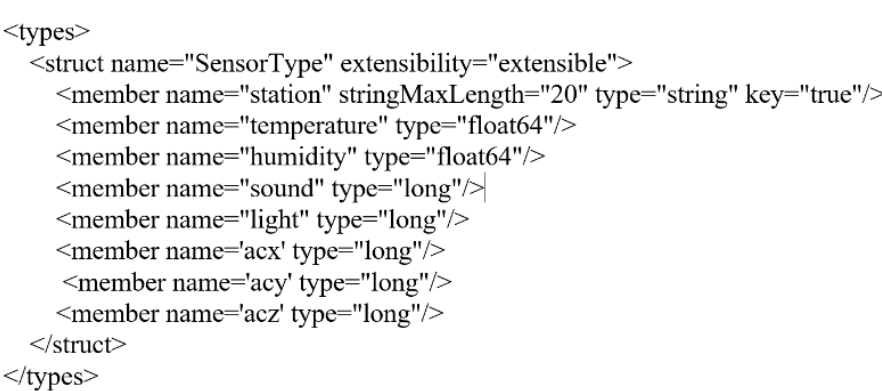
Figure 8. Physical connection of sensor and Raspberry Pi.